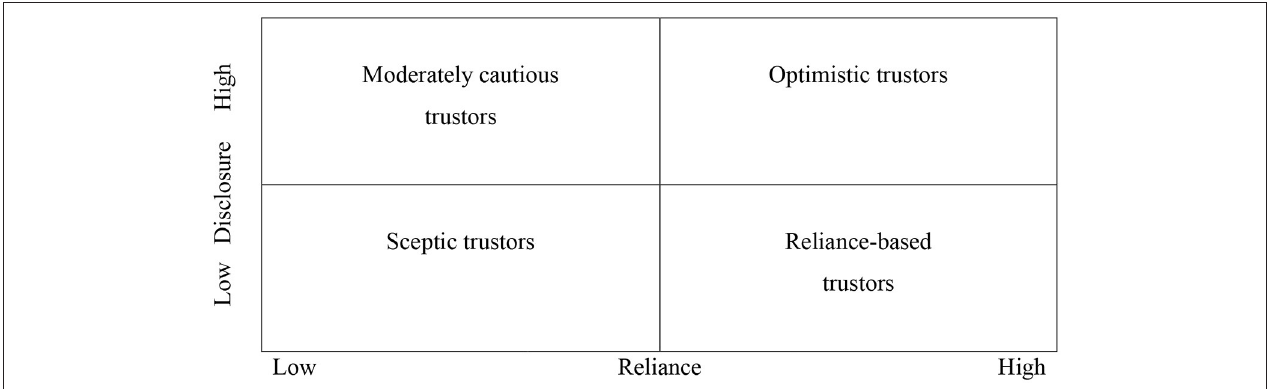
FIGURE 3 | Four trust